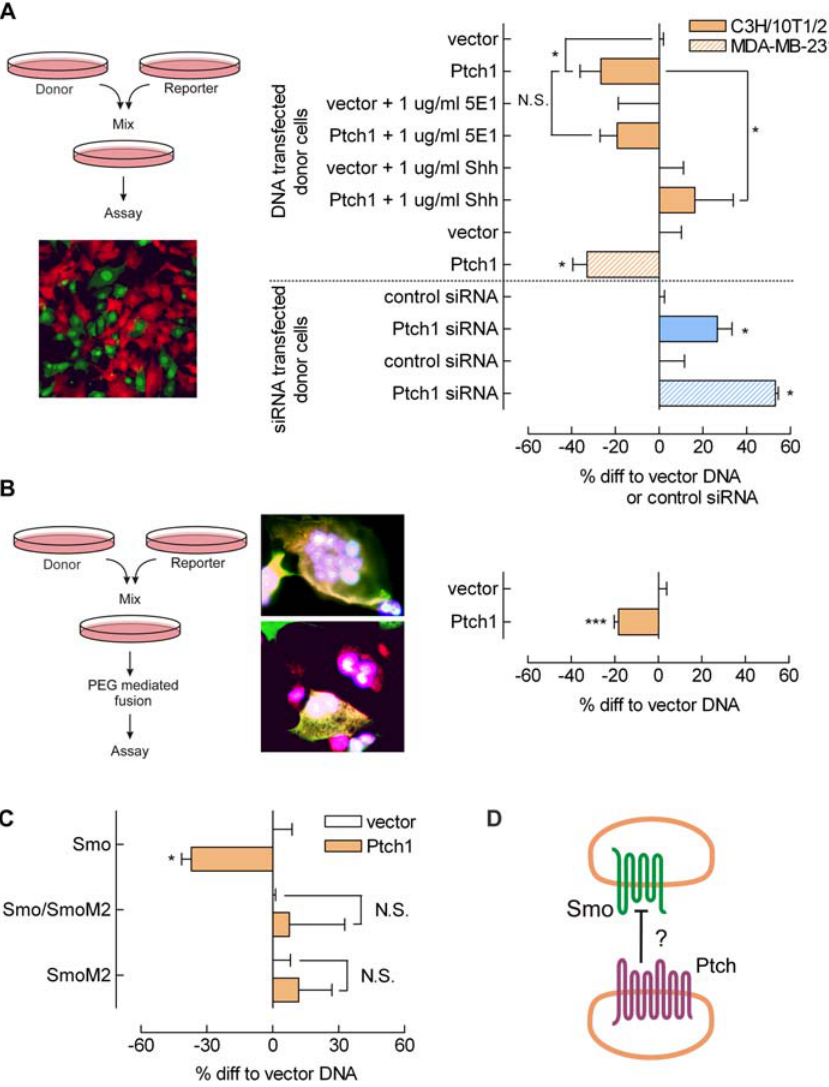
Figure 3. Ptch1 Inhibits Smo Intercellularly (A) Detaching and mixing of two populations of fluorescently labelled cells resulted in a homogenous mixture with intimate cell–cell contacts. The procedure is summarized in the left panel. Original magnification is 400 3 . Intercellular capacity of Ptch1 to inhibit Smo was assessed by mixing reporter cells overexpressing Smo and a Gli reporter with Ptch1-overexpressing donor cells. The observed decrease in Gli reporter activity could not be inhibited by the addition of 1 l g/ml 5E1 Shh-blocking antibody. Exogenously added Shh (1 l g/ml) was capable of abolishing the Ptch1-mediated inhibition. Transfecting donor cells with Ptch1 siRNA reversed the inhibitory effect (blue bars). MDA-MB-231 breast carcinoma cells (hatched bars) showed a response similar to the C3H/10T1/2 fibroblasts’. Donor cells were transfected, washed (16 h post transfection), mixed with reporter cells, and lysed after 6 to 8 h. Shown are RLU values corrected for an internal CMV Renilla luciferase control, expressed as percent differences relative to control-transfected donor cells (vector DNA or scrambled control siRNA). ( n (cid:1) 4; *, p , 0.05; ***, p , 0.005). Depicted is the mean 6 SEM. (B) Fusion of reporter cells with Ptch1 overexpressing donor cells showed a decrease in Gli reporter activity comparable in magnitude to the inhibition observed in mixed cells. Right panel: treating fluorescently labelled cells with PEG1500 4 h after mixing resulted in multiple nuclei per cell and composite cell colours, indicating successful cell fusion. Magnification is 1,000 3 . Statistics and incubation times are as in (A). (C) To assess the specificity of Ptch1 acting on Smo, reporter cells expressing the Ptch1-insensitive mutant SmoM2 (as indicated on the y -axis) were mixed with donor cells. The loss of inhibition indicates the specificity of Ptch1 acting through Smo in the mix-and-match setup. Statistics and incubation times are as in (A). (D) Shown is a model for the proposed intercellular action of Ptch1 inhibition following the results obtained in the mix-and-match experiments. DOI: 10.1371/journal.pbio.0040232.g003